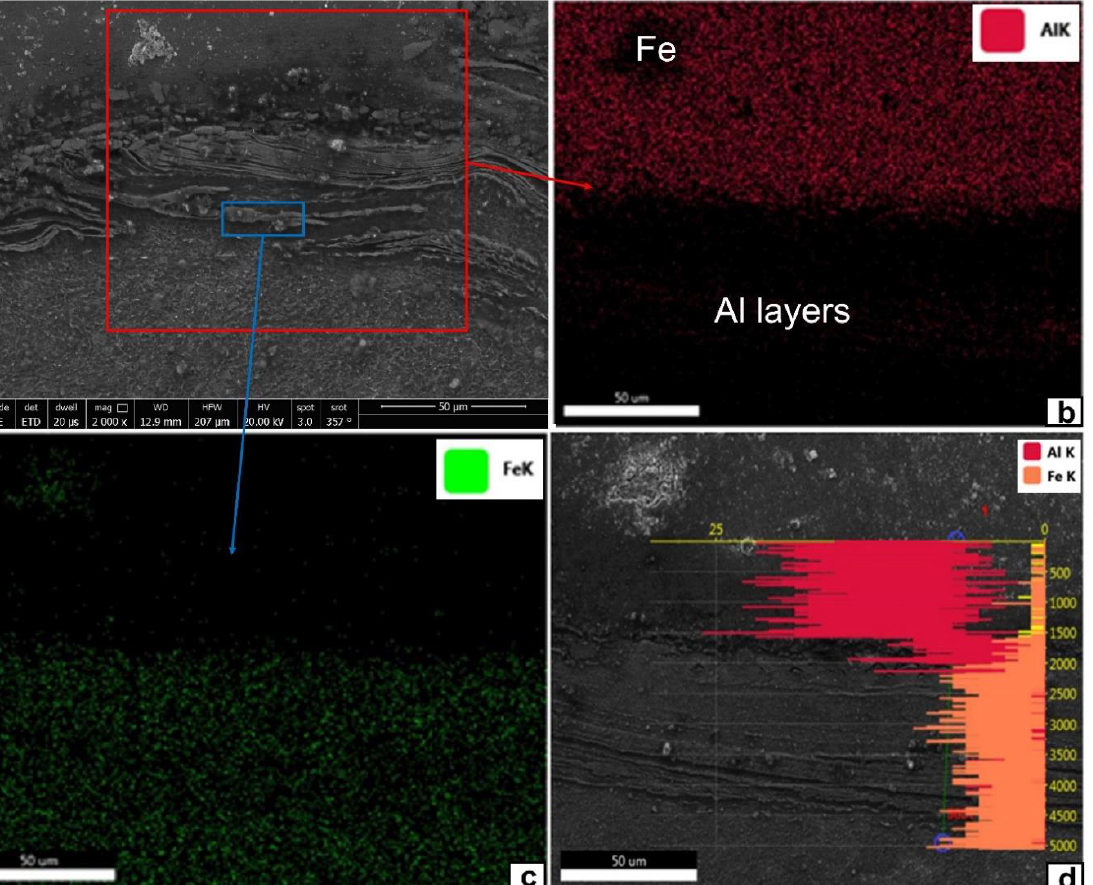
Figure 6. EDS analysis of one of the layers located at the aluminum/steel interface produced with high FSP rotation speed of 1500 rpm and pin length of 3 m: ( a ) SEM image of one of the lamanater layers and ( b ) EDS analysis of the red box in ( a ).